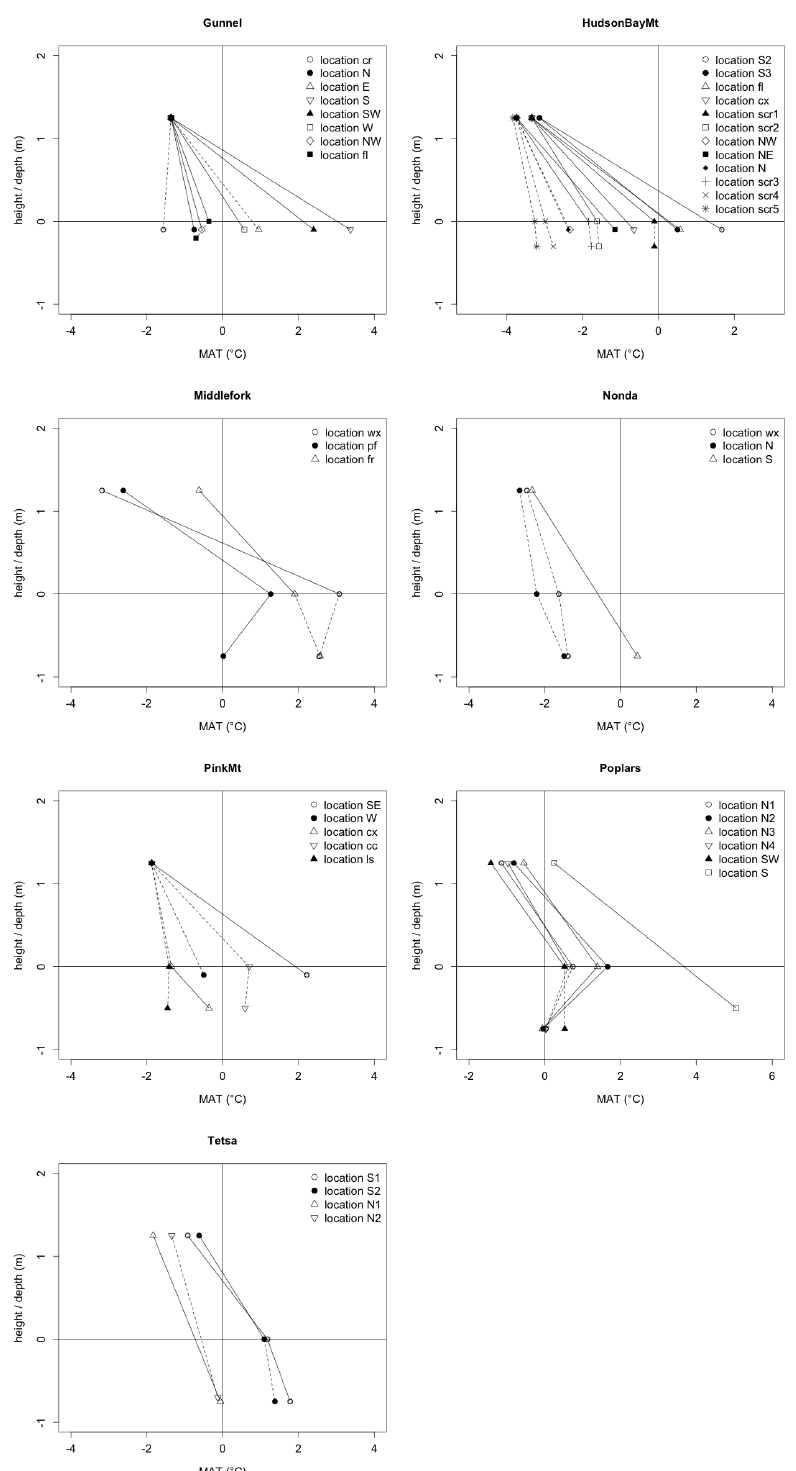
Figure 3. Overview of all thermal profiles measured at 44 locations within the seven field sites. The temperatures at 1.4m height are the mean annual air temperatures (MAAT). Dashed lines indicate offsets below the inward uncertainty (Offset< U offset / 2) of these offsets (Sect. 3.2). Solid lines indicate significant